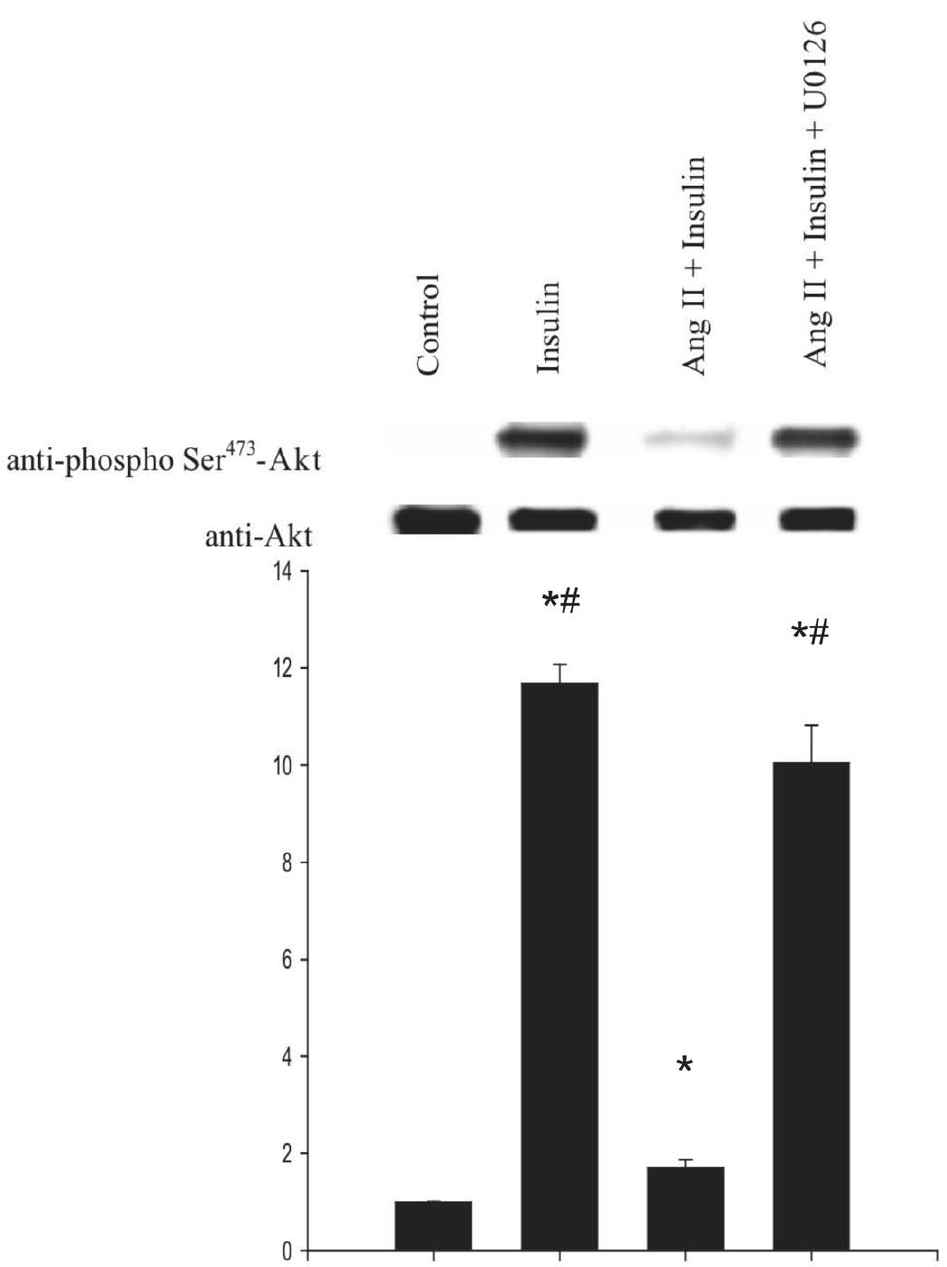
Figure 5. Effect of the MEK inhibitor U0126 on insulin-stimulated Akt phosphorylation. L6 myotubes were treated with U0126 (10 m M) for 30 min prior to addition of Ang II (10 nM) for 30 min with subsequent stimulation by insulin 100 nM for 60 min. Western blots were probed with anti-phosphoSer 473 -Akt and anti-Akt antibodies. The blot is representative of three independent experiments. Results are expressed as the fold increase of the ratio of phospho-Akt/Akt over controls (means 6 s.d.). (* P , 0,05 vs control, # P , 0,05 vs Ang II +